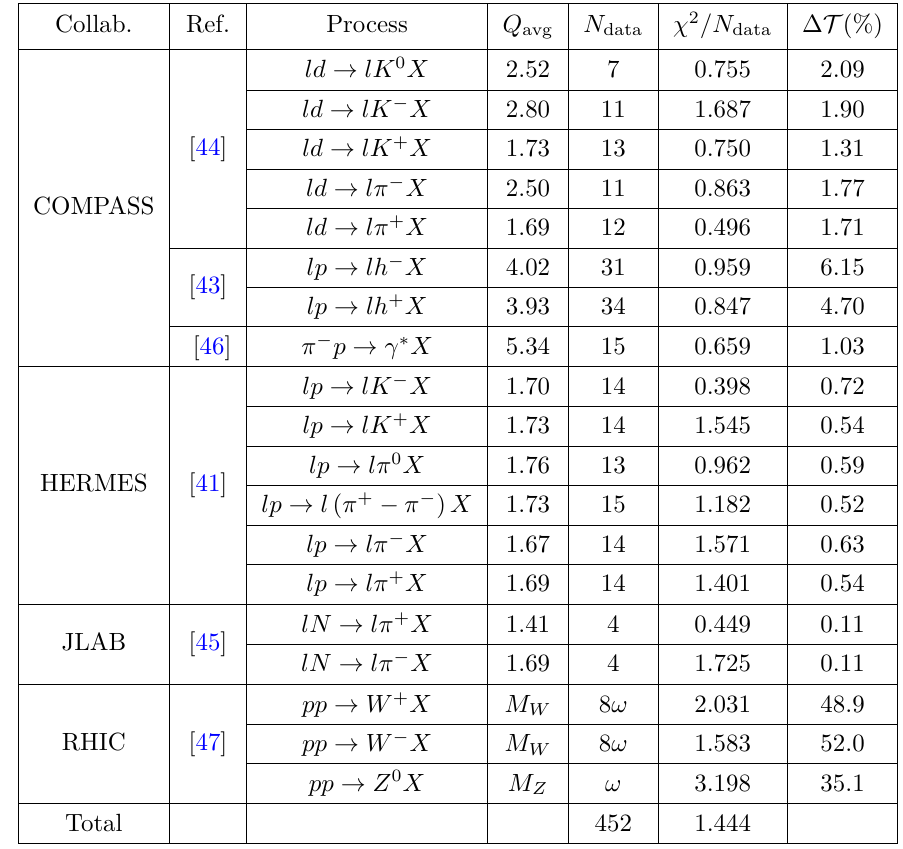
Table 4 . The distribution of χ 2 for each data set for the fit 2a in table 1. The column ∆ T is a measure of the sensitivity of the fit to the DGLAP evolution